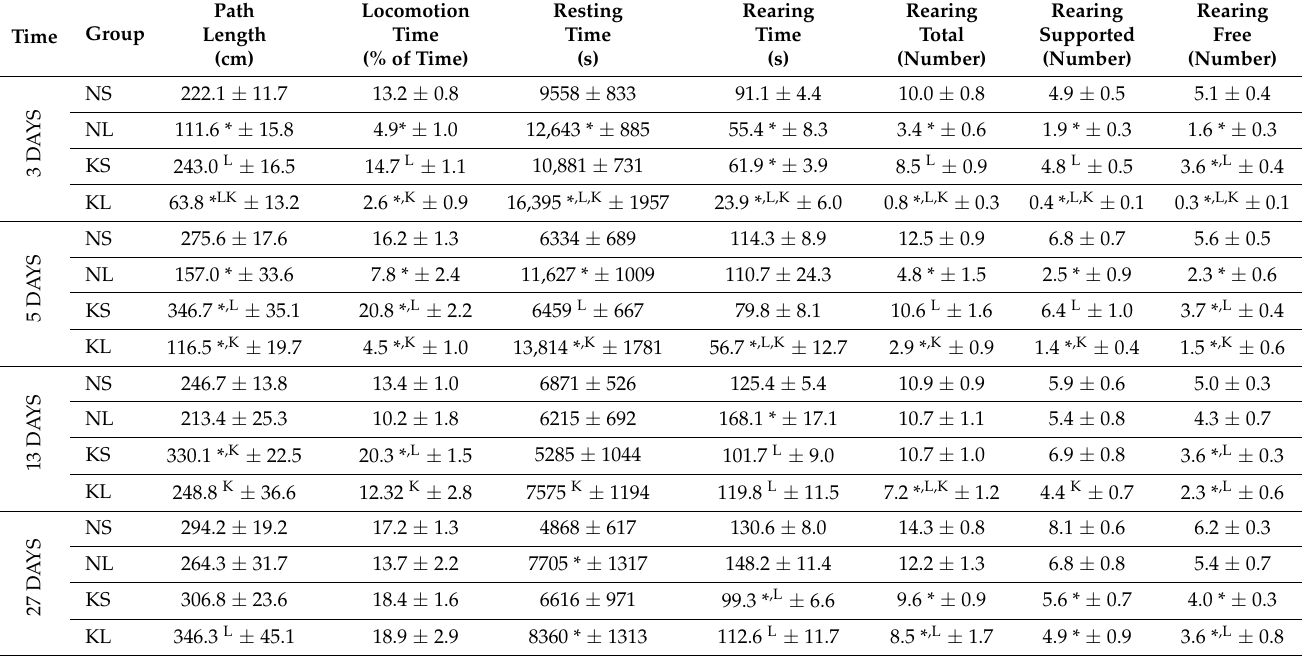
Table 1. Analysis of spontaneous rat behavior. Data presented as path length; locomotion, resting, and rearing times; number of all rearings, side wall rearings (supported), and free rearings (unsupported) measured in actome- ters, showed as mean raw values ± SEM. Analysis was performed at time-points 3, 5, 13, 27 days after brain surgery. Animals were kept on ketogenic diet for 3 weeks in advance. p value ≤ 0.05 was set as significance threshold and marked as * vs. normal diet + sham (NS group), L vs. normal diet + 6-OHDA lesion (NL group), K vs. keto- genic diet + sham (KS group), KL stands for ketogenic diet + 6-OHDA lesion group. Repeated measure ANOVA with LSD post hoc test for analysis in time and 3-way ANOVA with LSD post hoc test for analysis of total val- ues were performed. Number of animals in groups was: for 3 days, n = 19–26; for 5 days, n = 8–12; for 13 days, n = 9–16; for 27 days, n =